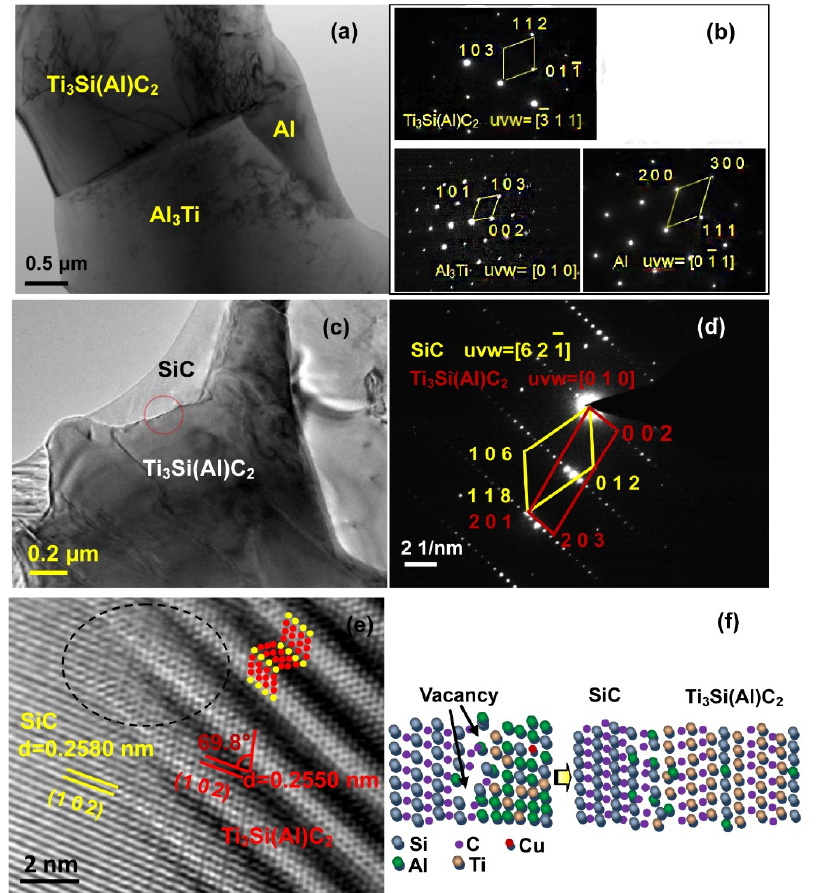
Figure 11. TEM investigations of the infiltrated sample: ( a , b ) SiC ceramic infiltrated with Al base alloy at 900 °C for 0.5 h, ( c – e ) SiC ceramic infiltrated with Al base alloy at 900 °C for 6 h, ( f ) schematic alloy at 900 ◦ C for 0.5 h, ( c – e ) SiC ceramic infiltrated with Al base alloy at 900 ◦ C for 6 h, ( f ) schematic diagram of Ti 3 Si(Al)C 2 formation process. diagram of Ti 3 Si(Al)C 2 formation